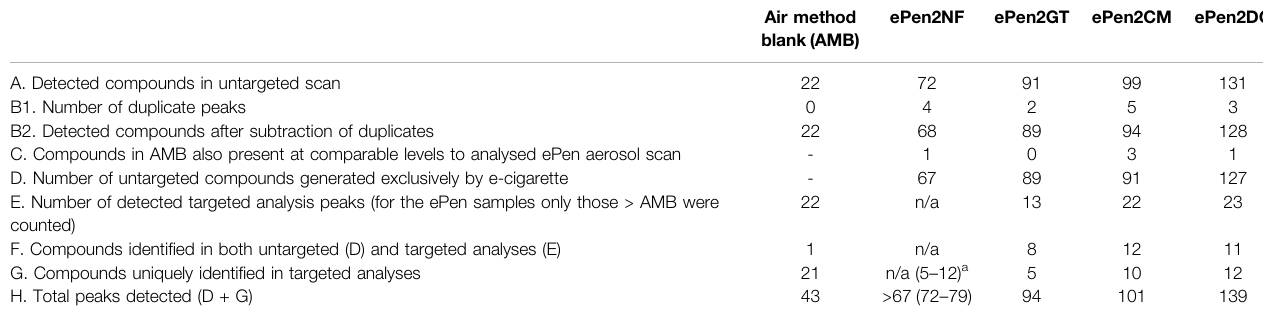
a Figureinparenthesisisanestimateforthenumberofcompoundsinthetargetedscanoftheun fl avorede-cigaretteaerosol;theestimateusedwastherangeoftargetedanalytesdetected with the fl avored e-cigarettes.